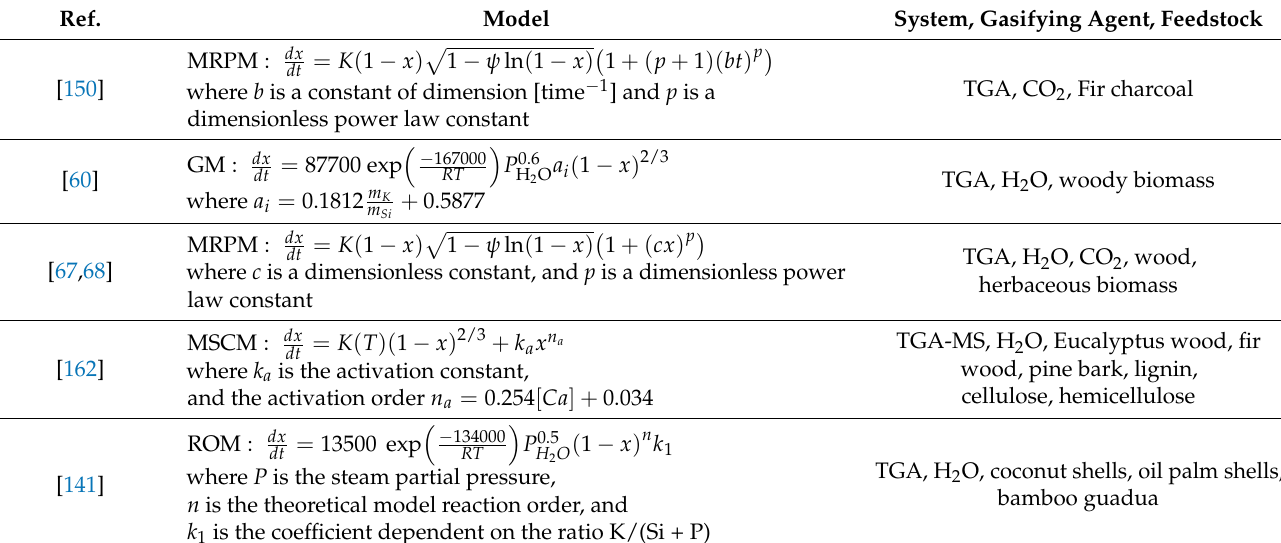
Table 6. Different kinetic models incorporating the effect of inorganic species on gasification